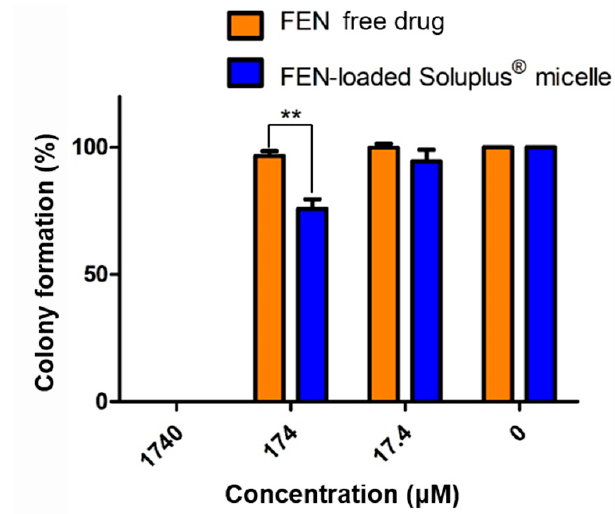
Figure 5. In vitro clonogenic assay of free fenbendazole (FEN)- and FEN-loaded Soluplus ® micelle- treated A549 cell line, ** p < 0.01.